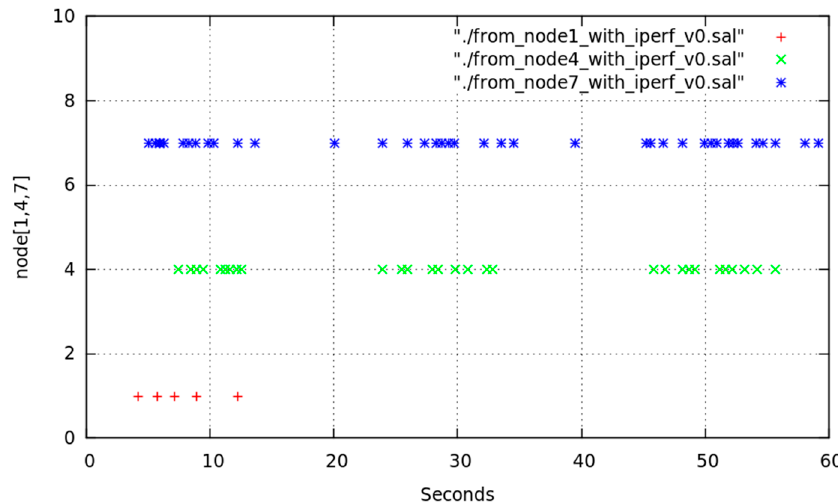
Figure 21. OLSR messages detected by node6 with channel 7 interferences at t = 10, t = 30 and t = 50.